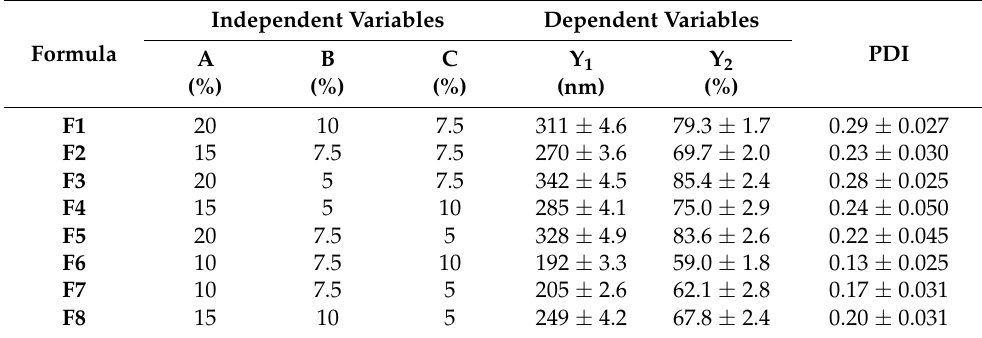
Table 2. Experimental runs for different ATO-NLCs created by BBD and their observed depen- dent